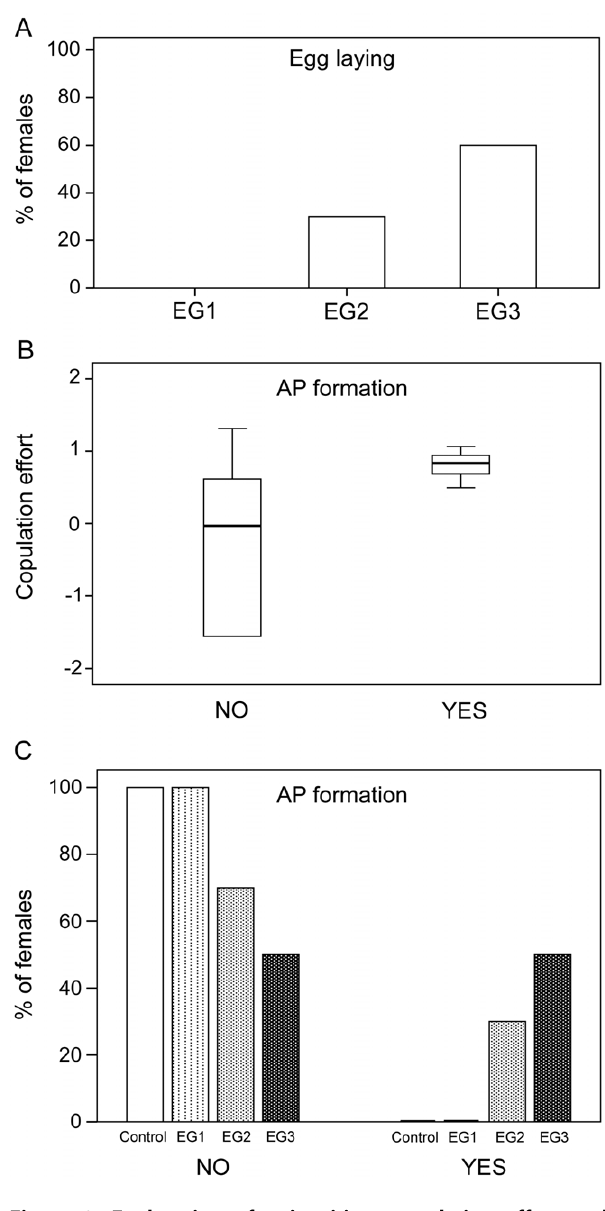
Figure 2. Exploration of oviposition, copulation effort and amorphous plug (AP) formation. A, share of egg-laying females per experimental group (EG1=1 male, EG2=3 males, EG3=5 males); B, copulation effort (number of insertions and copulation duration combined) in females with and without AP; C, share of females per EG with and without